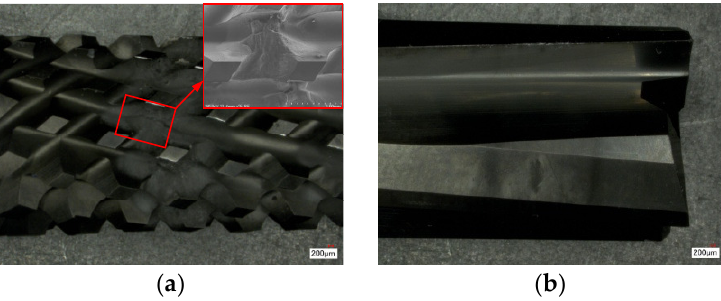
Figure 5. The chip removal of the cutting tools when the coating fell off seriously, ( a ) the chip removal of the rhombic milling cutter and ( b ) the chip removal of the staggered helical milling cutter.